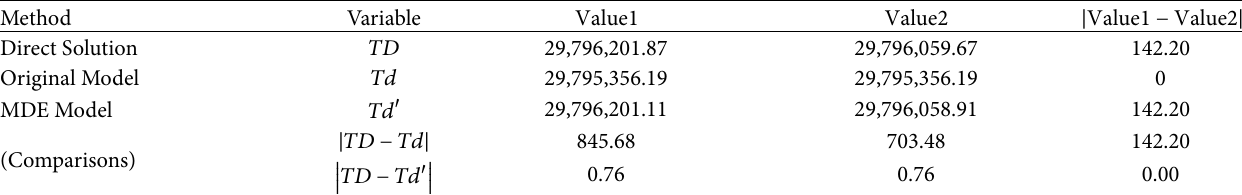
Table 5: Liaoyang results and comparisons of three methods. Unit: m.